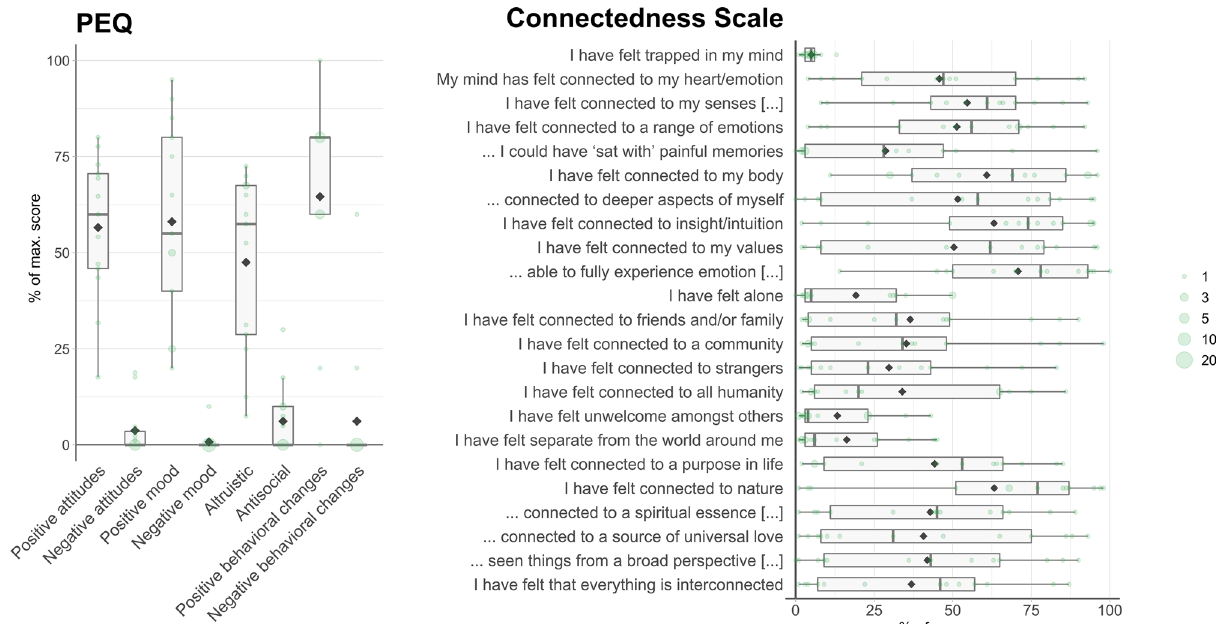
Figure 2. Subacute subjective effects of Kambô. Subacute effects (n = 13) were assessed with the PEQ and the CS and are displayed as box plots for the dimensions or items of the two questionnaires. In comparison to Table 3, the box plots provided here illustrate the data